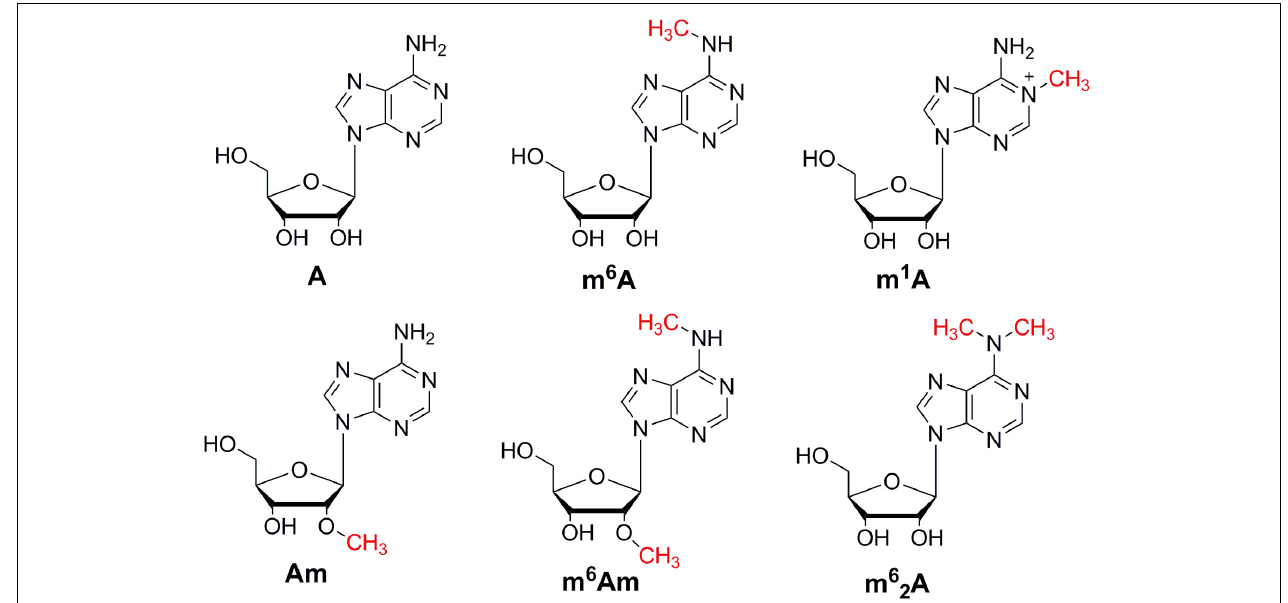
FIGURE 1 | The chemical structures of A, m 6 A, m 1 A, m 6 Am, Am, and m 6 2 A.